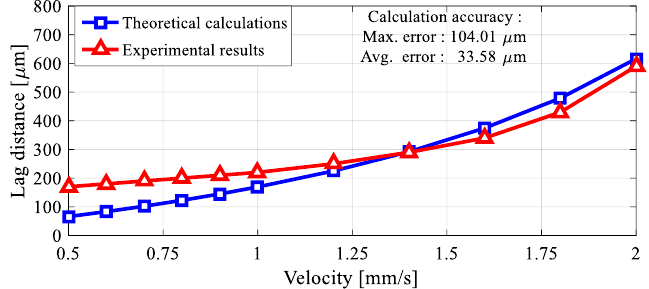
Figure 15. At higher velocities of about 1.4 mm/s, the phase difference is characterized by an exponential increasing trend, and at lower speeds with linearized phase difference characterization, as expected. It is obvious that the phase difference falls below 150 µ m as the same linear change is likely to continue even at small speeds of 0.5 mm/s. This is an indication that non-delayed positioning can be performed by neglecting the phase difference at the speed requirements of the nanometer range, which will be needed especially in lab-on-a-chip